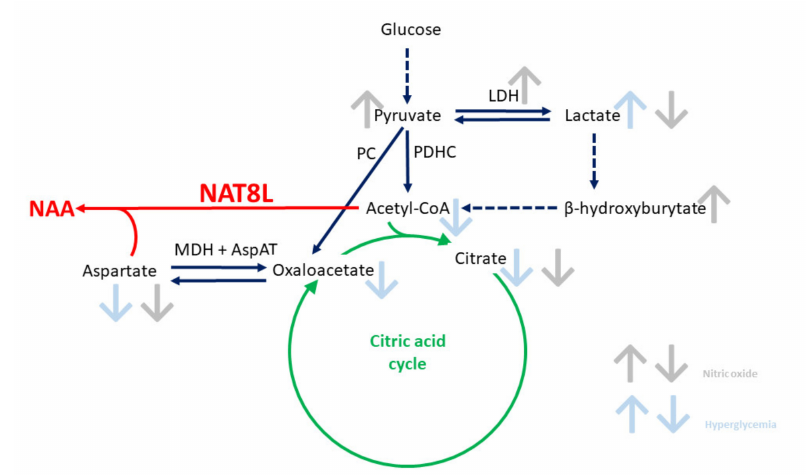
Figure 1. Graphic presentation of the background of this study background: the impact of neurotoxic factors on the N -acetylaspartate network related to neuronal energy pathways. Abbreviations: AspAT: aspartate transferase; LDH: lactate dehydrogenase; MDH: malate dehydrogenase; NAA: N -acetylaspartate; NAT8L: aspartate N -acetyltransferase (or Shati protein); PC: pyruvate carboxylase; PDHC: pyruvate dehydrogenase